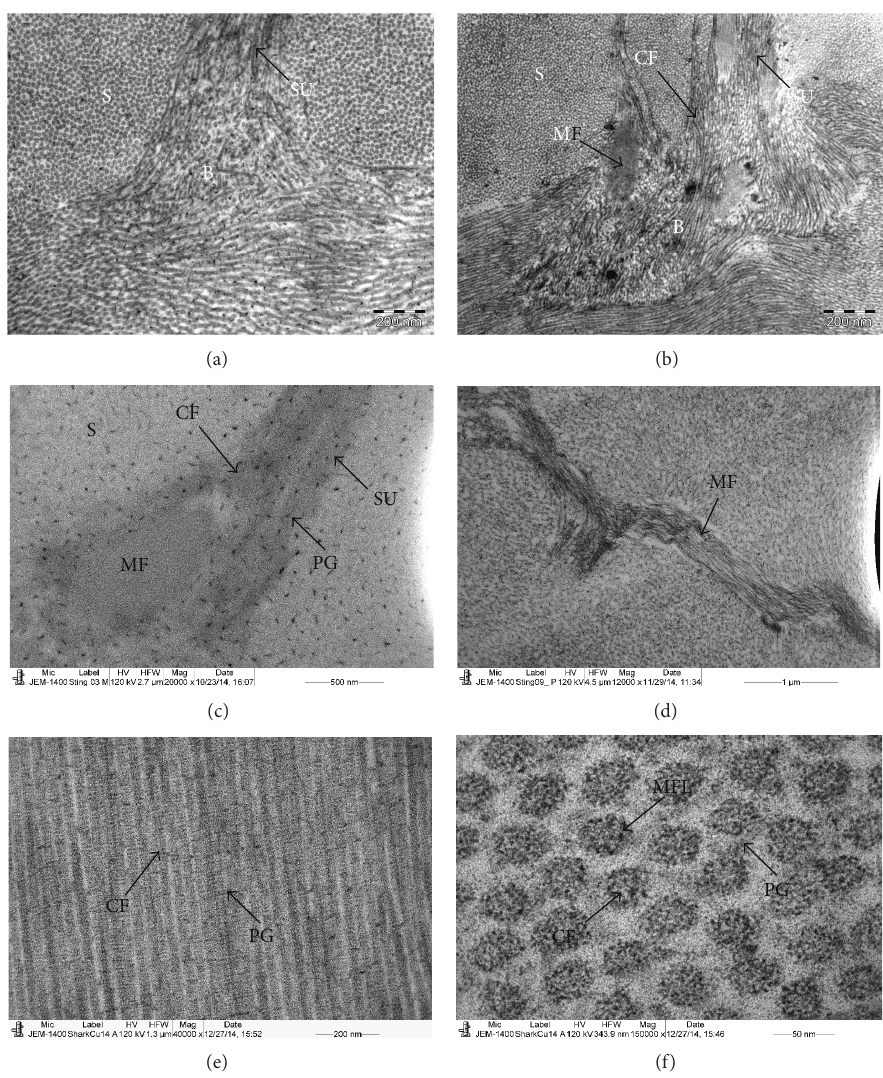
Figure4:Electronmicrographofstingraycornea;(a)posteriorpartofasinglesuturecontainingrandomlyrunningCFsembeddedwithinthe lamella. (b) Basal part of multiple sutures containing randomly running CF which were embedded within the lamella. Group of microfibrils were present among the CF. (c) Posterior part of the suture showing presence of PGs on the CF but not on the microfibrils; (d) longitudinally running microfibrils of suture not surrounded by CF; (e) electron micrograph of longitudinally running CF of the middle stroma of shark; (f) electron micrograph of cross section of CF of the middle stroma of shark. CF: collagen fibrils, L: lamellae, MFL: microfilament, PG: proteoglycans, S: stroma, and SU: